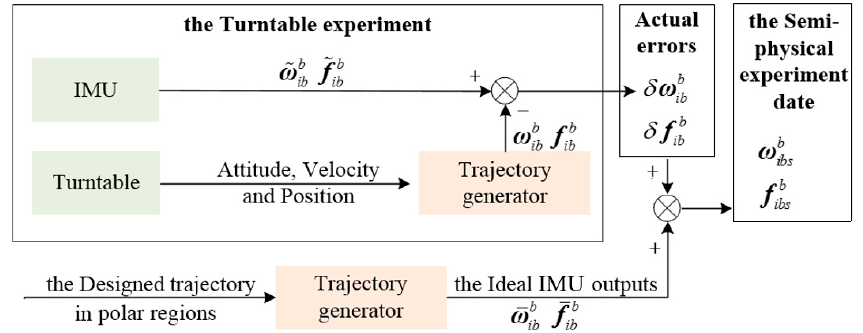
Figure 8. Description of signal flow to get the semi-physical experiment data.